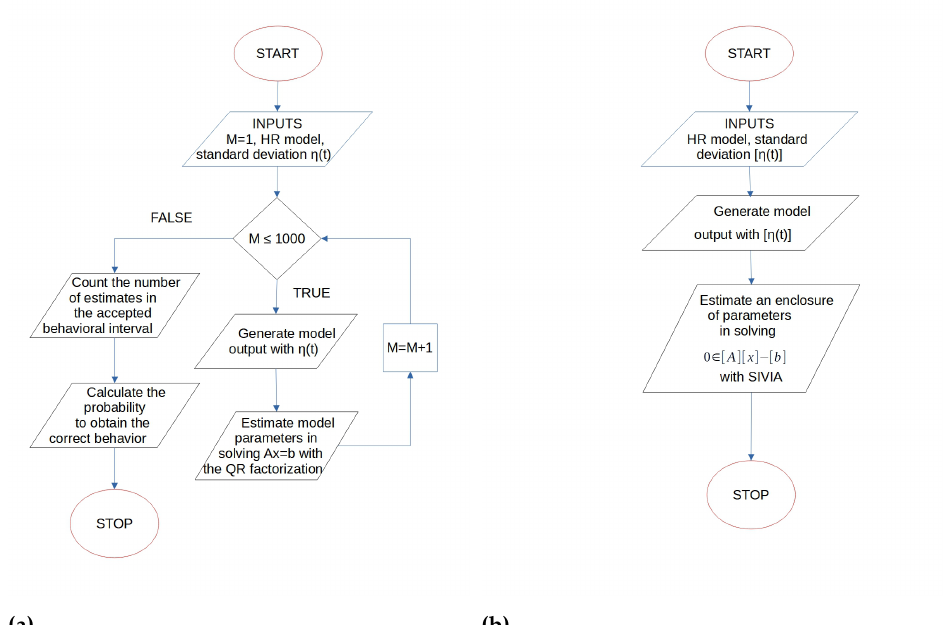
Figure 2. These two diagrams summarize the differences between the procedure presented in [5] and the one presented in this paper. ( a ) Diagram summarizing the stochastic procedure, presented in [5]. ( b ) Diagram summarizing the interval procedure, presented in this paper.